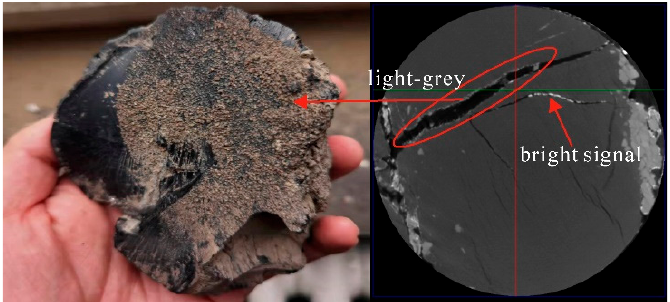
Figure 13. Proppant attached to the hydraulic fracture surface. In the CT scan, proppant is the light-grey signal, and the bright signal is likely pyrite. The characteristic was also observed in Ref. [2].